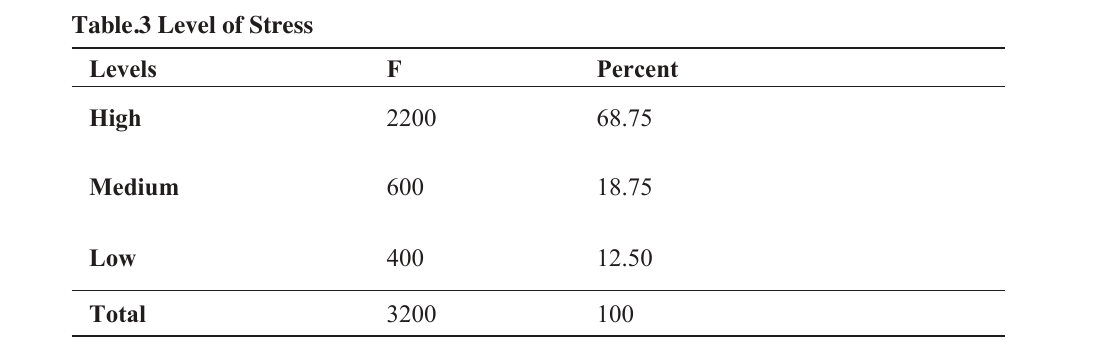
Table.3 Level of Stress